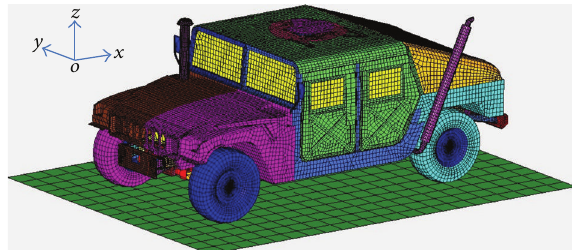
Figure 1: Finite element model of a military vehicle for blast protection design.